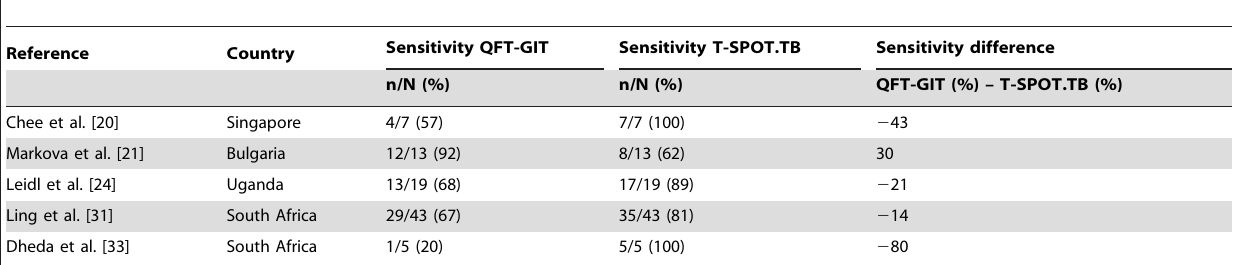
Table 2. Head-to-head comparison of sensitivity between QFT-GIT and T-SPOT.TB in HIV-infected patients with culture-confirmed